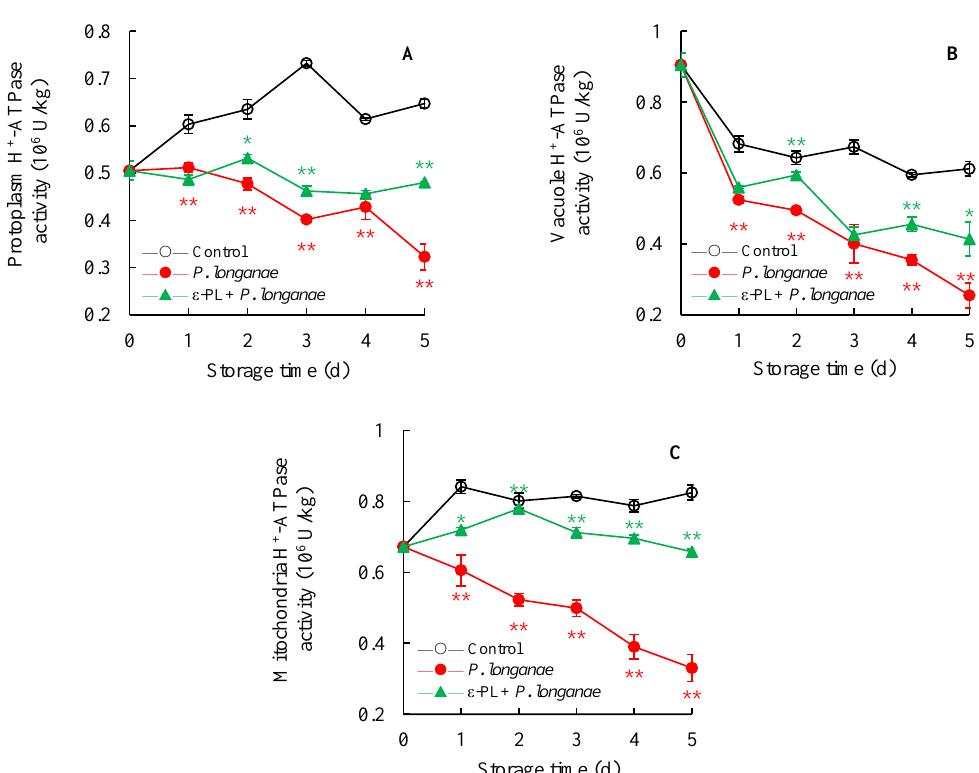
Figure 5. Effects of ε -PL treatment on activities of H + -ATPase in membranes of protoplasm ( A ), vacuole ( B ), and mitochondria ( C ) in pericarp of P. longanae -inoculated longans. Value presented in figure equals mean ± standard error of triplicate analyses, vertical bars express the standard error of mean ( n = 3). The mark ** represents the significant difference ( p < 0.05 or p < 0.01) between the P. longanae -inoculated longans and the control longans on each storage day. The mark * or ** represents the significant difference ( p < 0.05 or p < 0.01) between the ε -PL-treated P. longanae -inoculated longans and the P. longanae -inoculated longans on each storage day. , Control; • , P. longanae ; (cid:78) , ε -PL + P. longanae (cid:35)